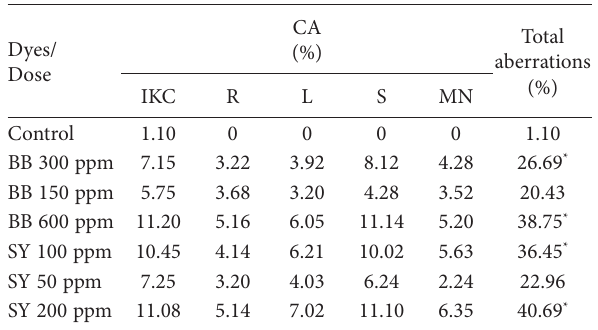
Table 2. Type and percentage of cellular aberrations induced by Brilliant Blue and Sunset Yellow food dyes on the meristematic roots of Allium cepa .